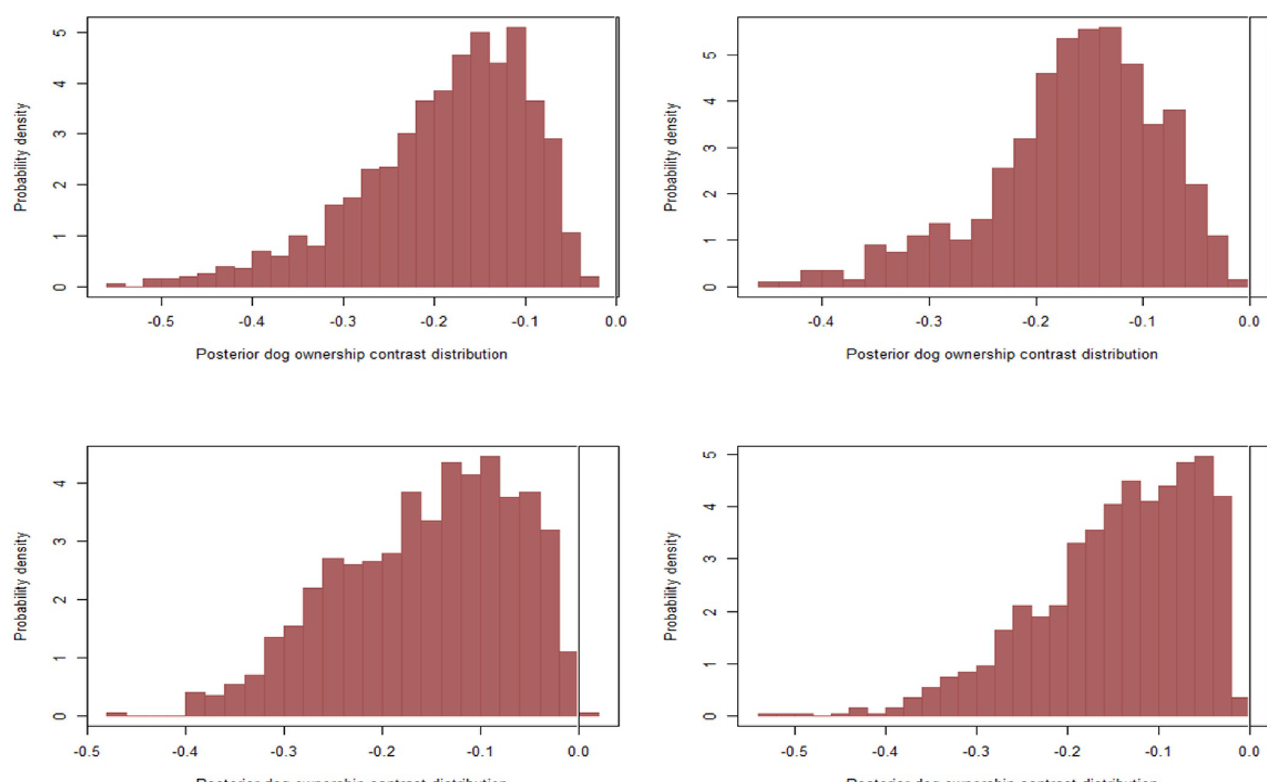
Fig 4. Posterior marginal contrast distribution demonstrating how the estimated probability of deaths was predicted to change, comparing bites from owned to free-roaming dogs at 35% vaccination probability to account for 3% of free-roaming (Top left), when the probability of vaccination was varied between 20% and 45% in each MCMC iteration(Top right), when the probability for owned dogs was varied between 35% and 60% and 30% for free- roaming dogs(Bottom left) and when we varied the probabilities between 25% - 75% for owned and 20%- 45% for free-roaming dogs(Bottom right).